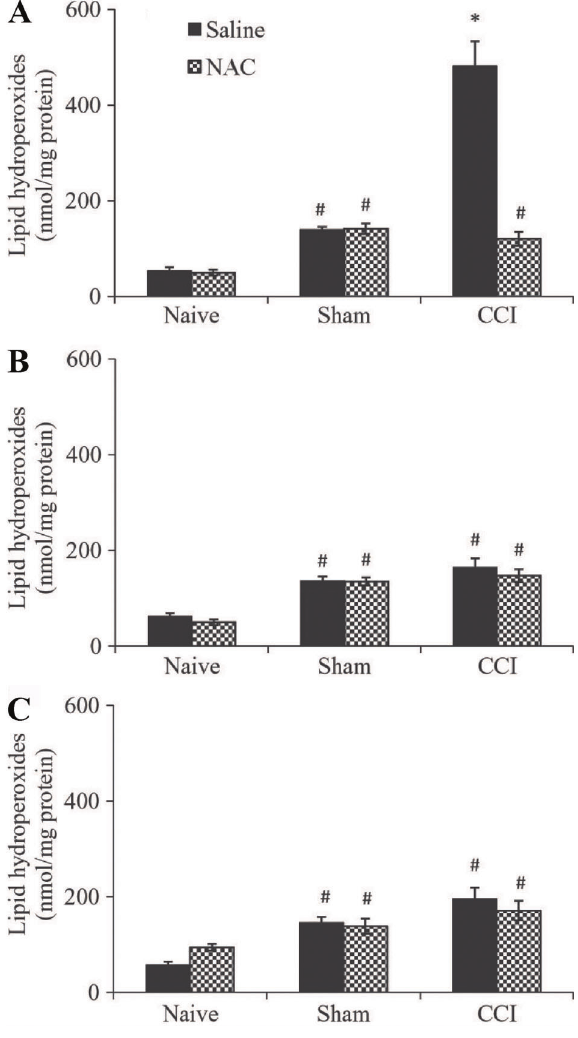
Figure 1. Lipid hydroperoxide levels in the spinal cord of chronic constriction injury (CCI) rats treated with N-acetylcysteine (NAC; 150 mg (cid:1) kg – 1 (cid:1) day – 1 ) or saline administered intraperitoneally for 1 ( A ), 3 ( B ), and 7 ( C ) days (n=6 animals/group). In Sham rats, all surgical procedures involved in the CCI were used except the ligature. Data are reported as means ± SE. *P o 0.05, compared to other groups. # P o 0.05, compared to naive group (three-way ANOVA followed by Tukey post hoc